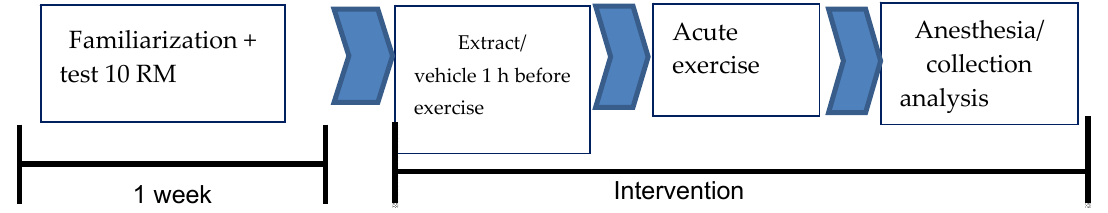
Figure 1. Diagram of the experimental protocol.